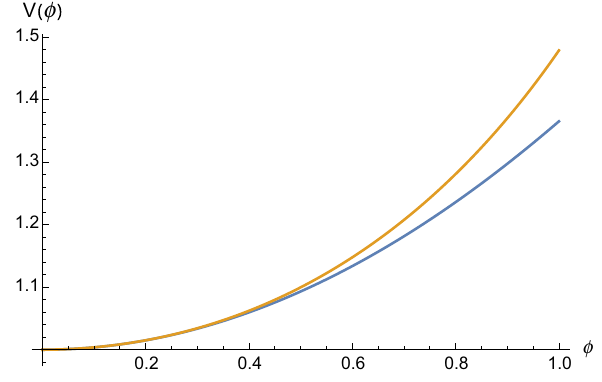
Fig. 1 Comparison between the axionic potential [6] (blue) and the hyperbolic potential used in [2] (yellow), for the same initial conditions